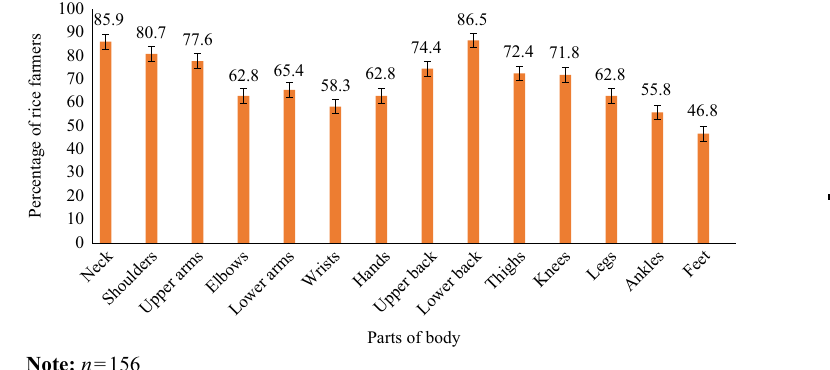
Figure 1. MSDs occurrence of rice farmers during the 6